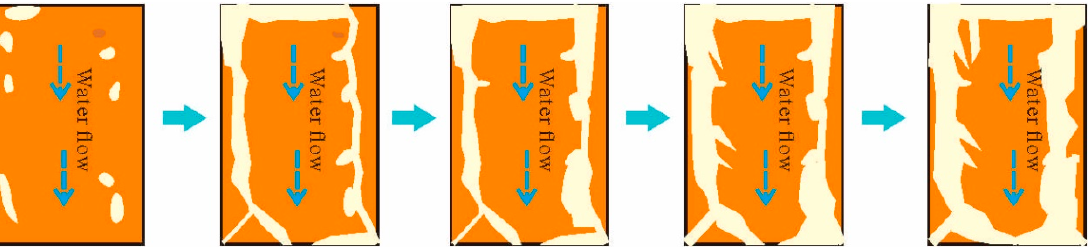
Figure 4. A schematic interpretation of the erosion process for different initial cross-sections of flow.